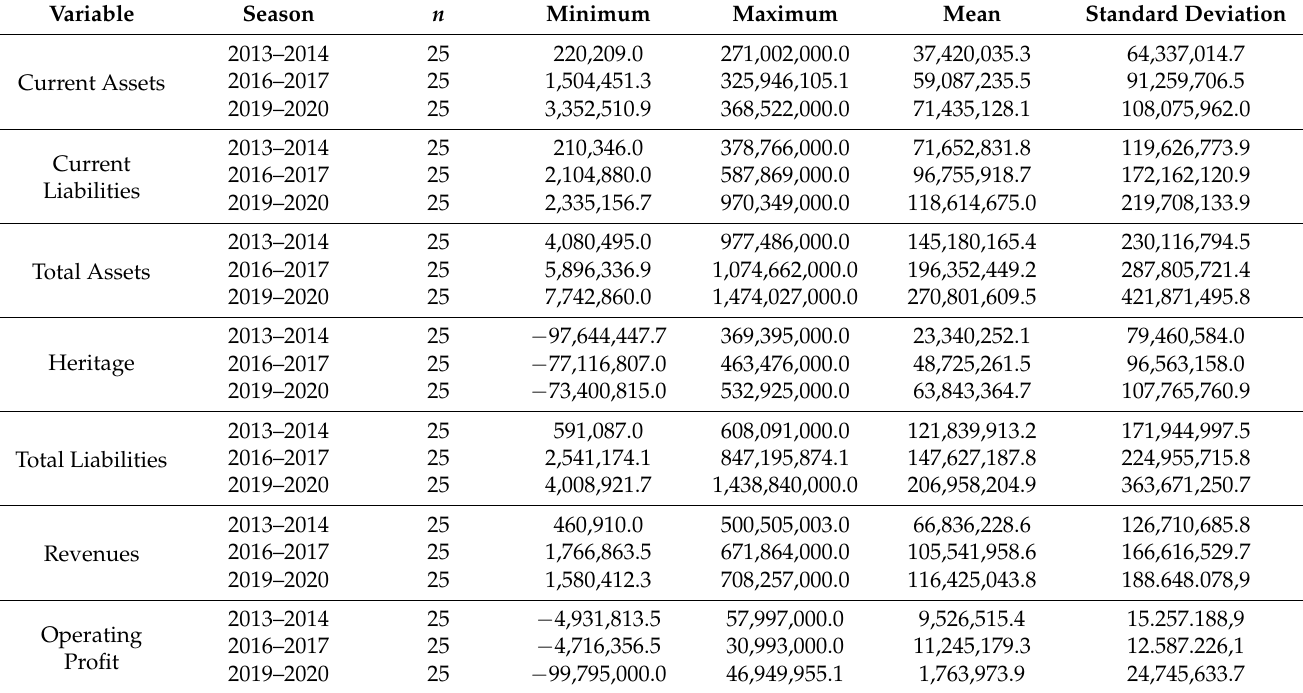
Table 1. Descriptive statistics of some of the most representative financial statement